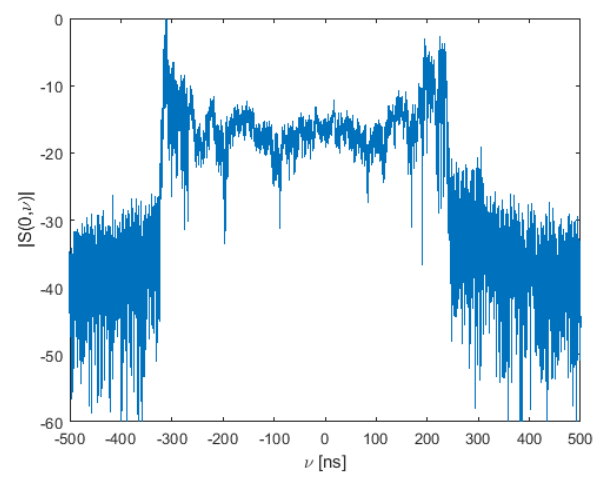
Figure 18. Doppler spectrum of the main component.